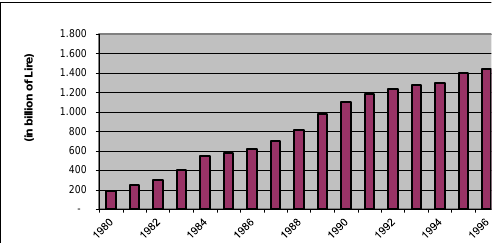
Figure 4: Growth of Expenditures for Sport Sponsorships (Italy)